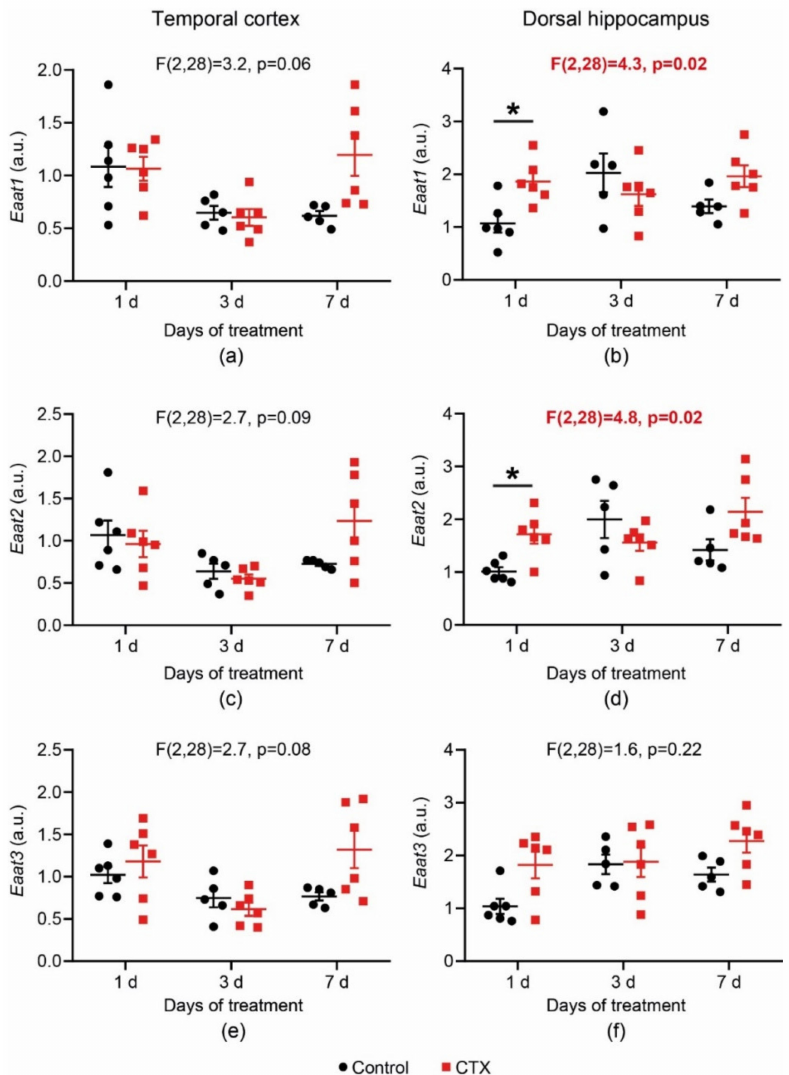
Figure 1. Changes in the mRNA expression level of Eaat1 ( a , b ), Eaat2 ( c , d ), and Eaat3 ( e , f ) in the temporal cortex (a,c,e) and dorsal hippocampus (b,d,f) after ceftriaxone (CTX) treatment. A two-way analysis of variance (ANOVA) (number of days of treatment × drug) was used. The t -test with Bonferroni correction was utilized for post hoc analysis. * Di ff erence between the control and CTX-treated group at p < 0.05. Each dot represents one